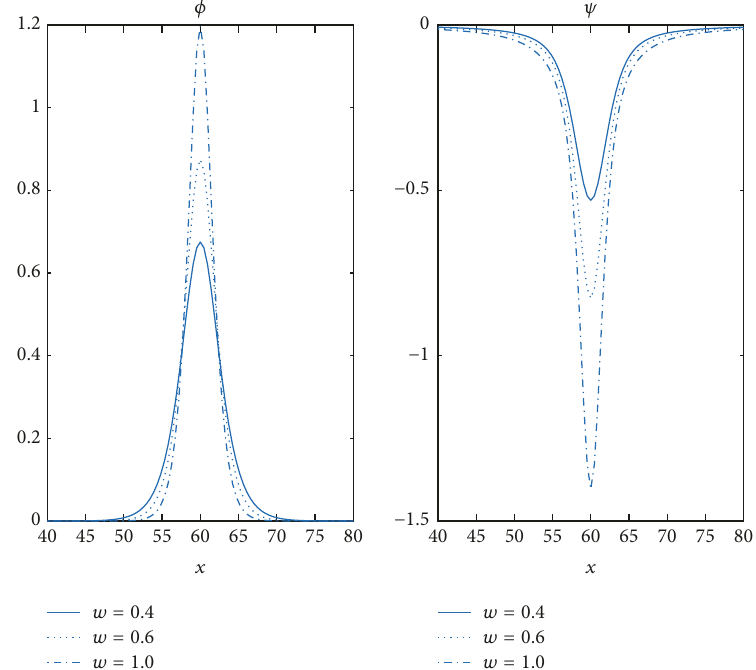
Figure 17: Comparison of solitary wave solutions of the SBO system for different values of the frequency 𝑤 .